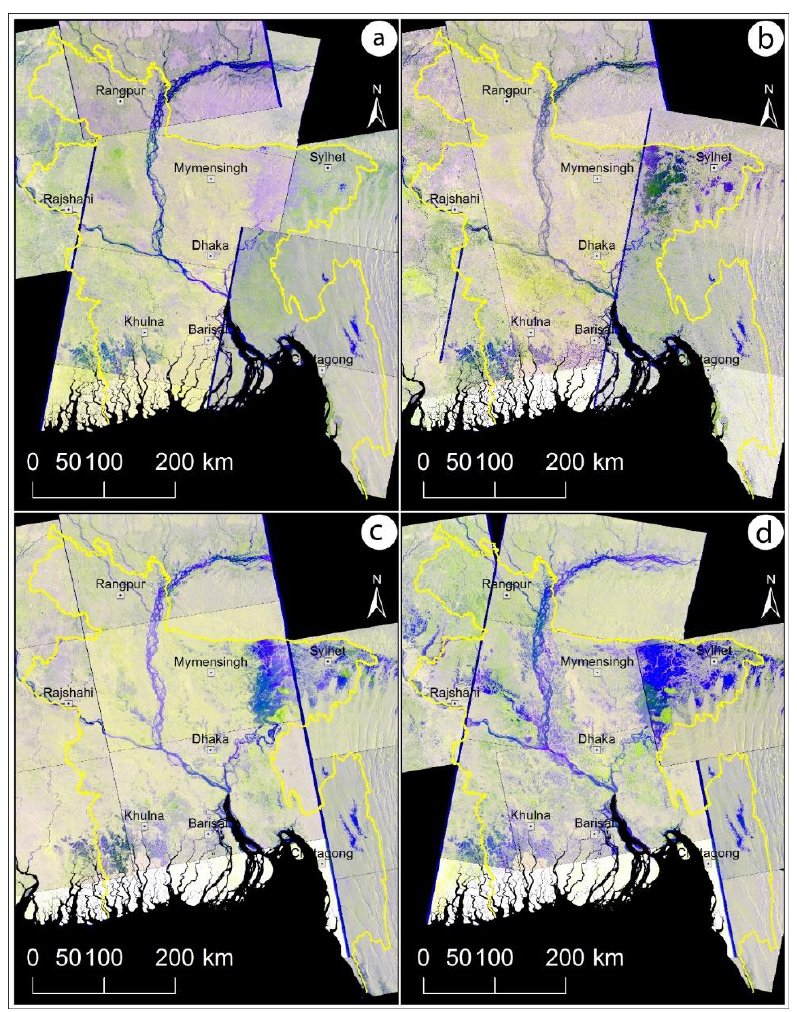
Figure 2. Sentinel-1 composites VH (red), VH (green), and VH/VV backscatter ratio (blue) images used for inundation mapping of ( a ) March, ( b ) April, ( c ) June, and ( d ) August 2017.